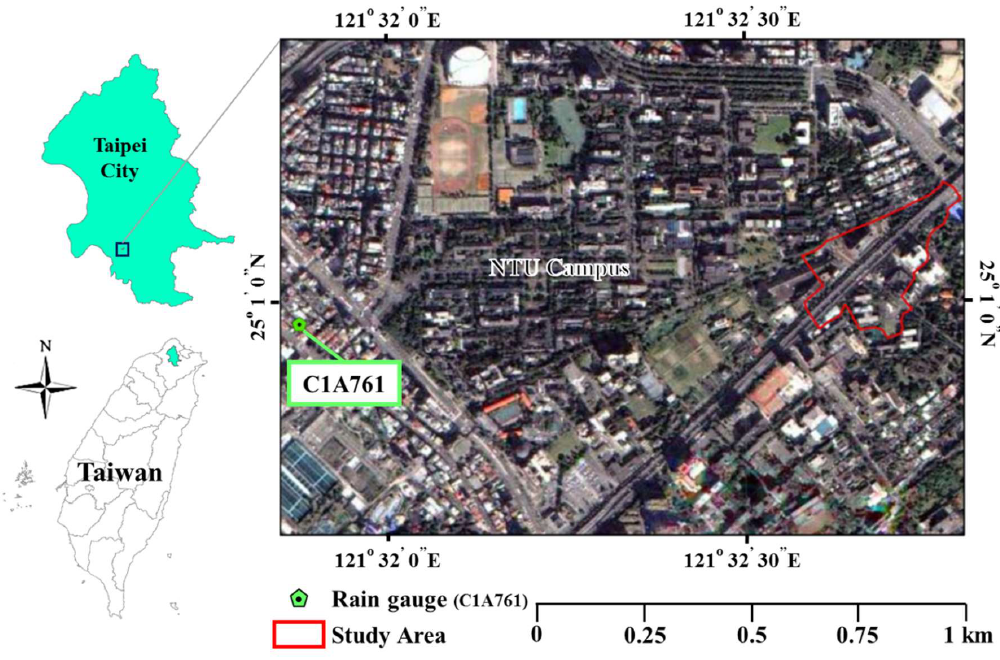
Figure 3. Study area (red polygon) at Gongguan, Taipei City, Taiwan.